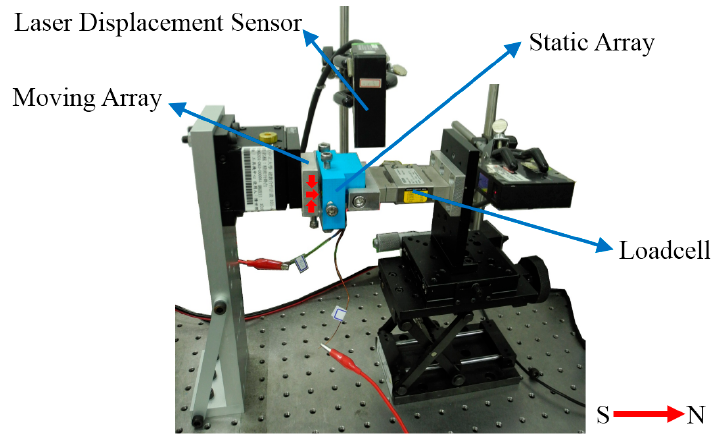
Figure 4. The measurement setup for a hybrid magnetic unit.